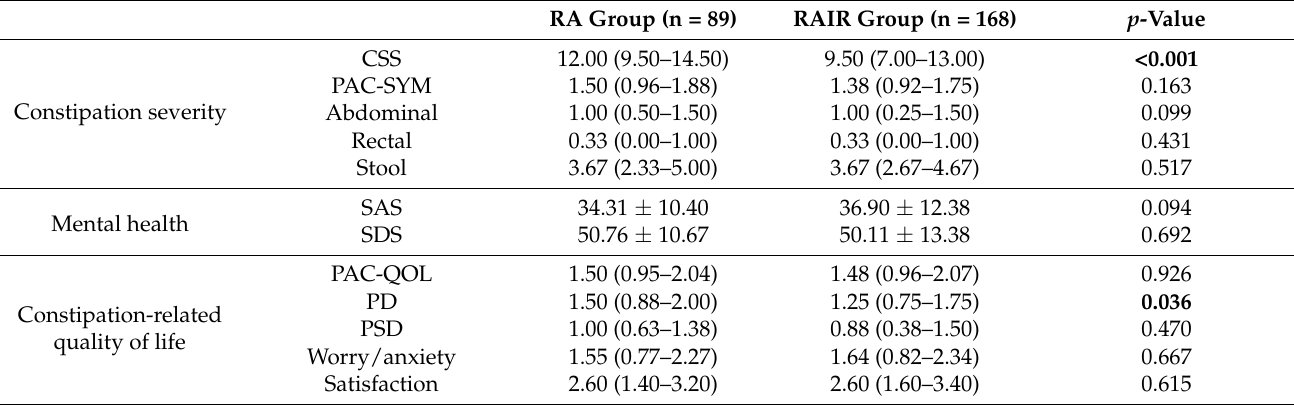
Table 2. The scores of different